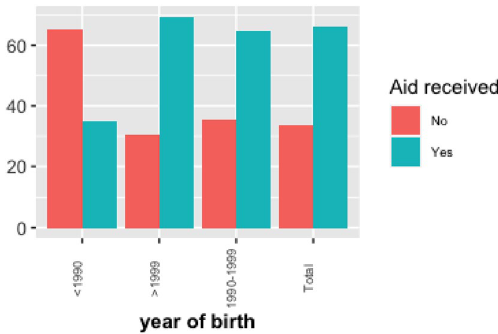
Figure 2. Student’s age and received support.